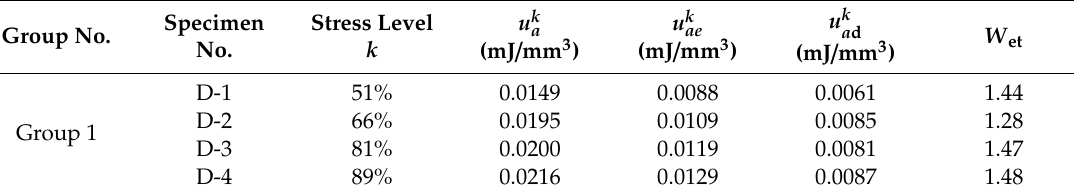
Table 6. Strain energy density of coal specimens in TJH coal mine. Group No.